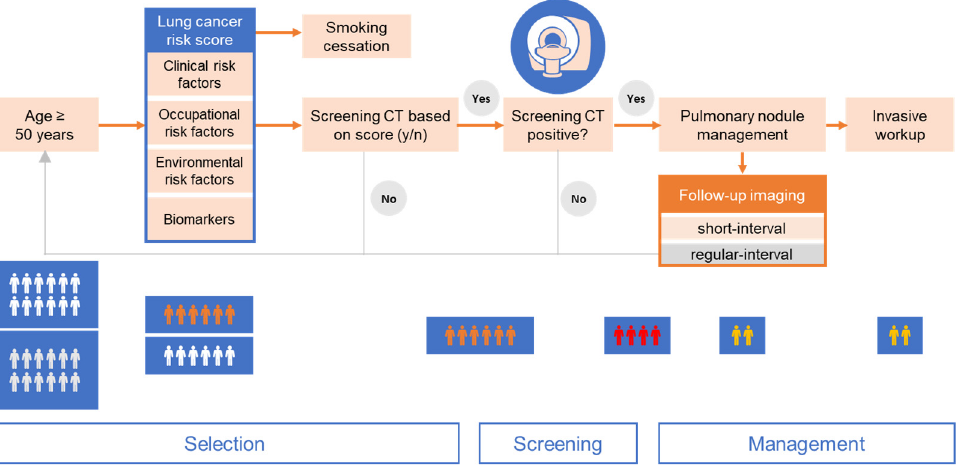
Figure 1. Three-step strategy to overcome current limitations in lung cancer screening by computed tomography (CT). Selection: Improved criteria basing on clinical, occupational, and environmental